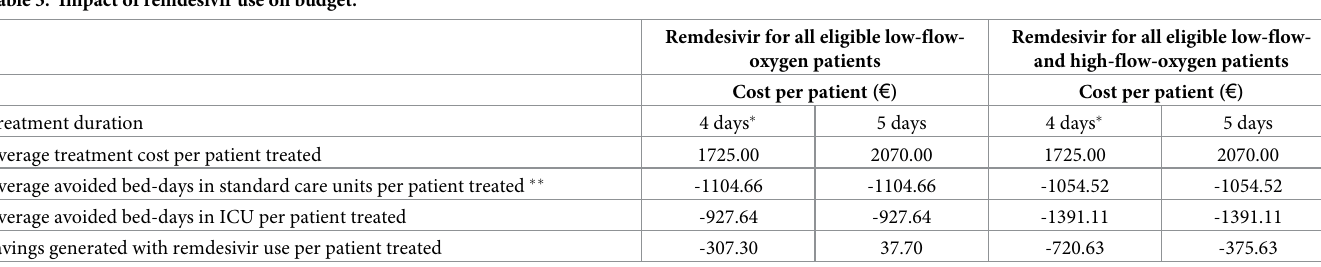
Table 3. Impact of remdesivir use on